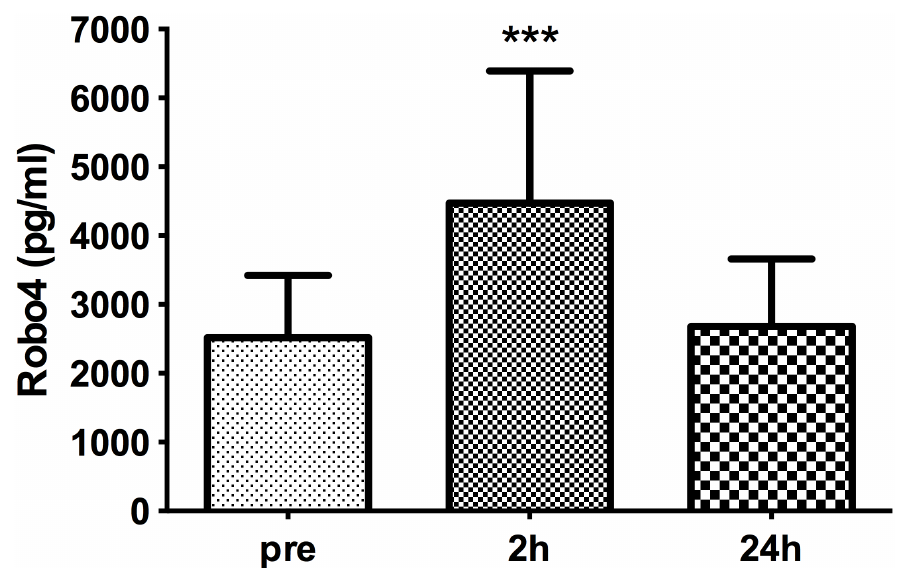
Figure 1. Plasma levels of Robo4 before and after cardiac surgery. Plasma levels of Robo4 increased 2 h post-cardiac surgery requiring cardiopulmonary bypass compared with pre-operative levels and those 24 h post-surgery. Data are presented as bar graphs with mean and SD concentrations (pg/ml) of Robo4; n=32, ***p , 0.001 compared with pre- and 24 h levels. doi:10.1371/journal.pone.0111459.g001 PLOS ONE |